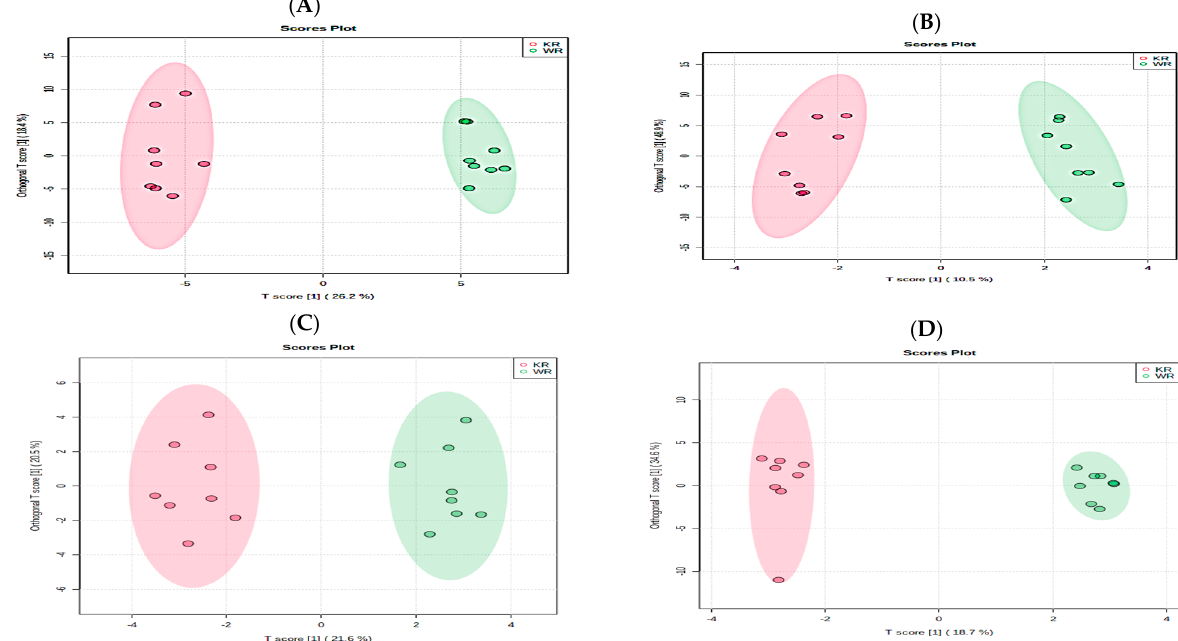
Figure 2. OPLS-DA score plots for brews of roasted Kaua’i coffee (KR, n = 3) and roasted Waialua coffee (WR, n = 3) for known ( A ) global metabolites, ( B ) positive ESI mode lipids, ( C ) negative ESI mode lipids, and ( D ) biogenic amines. = Kaua’i roasted (KR) and = Waialua roasted (WR).